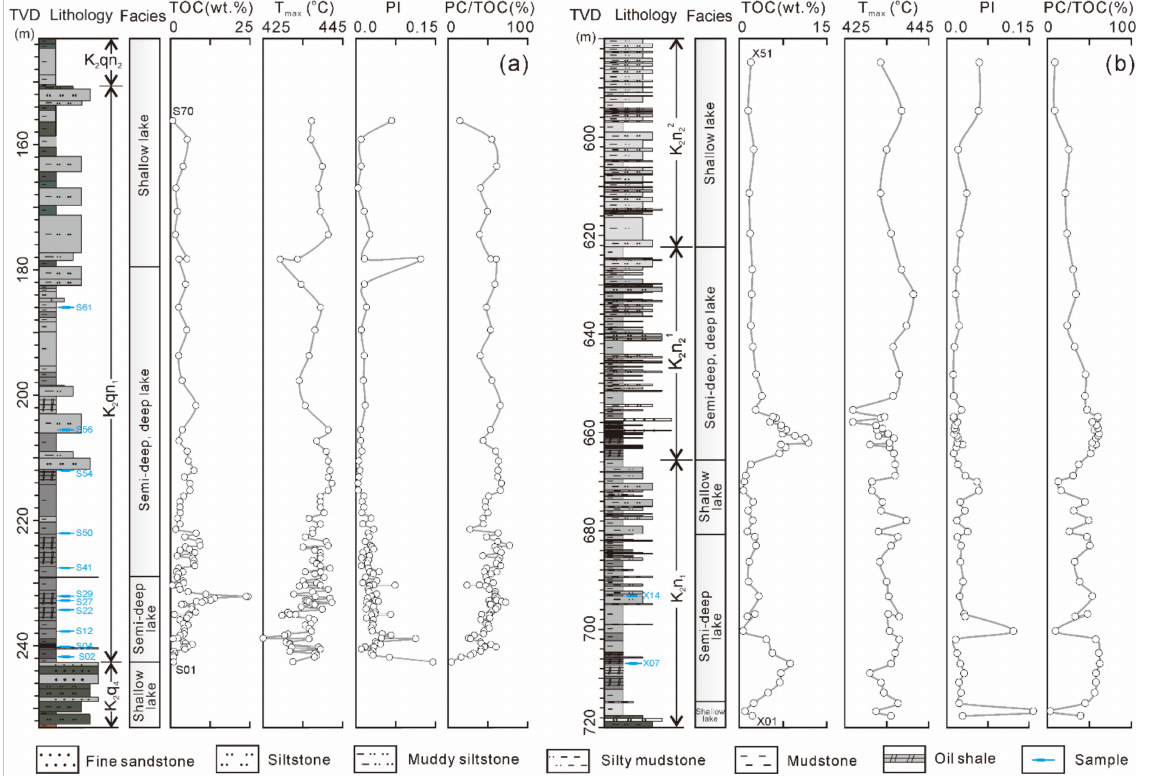
Figure 2. Lithologic profiles and sedimentary facies with position of measured samples from boreholes Ngn2 of the K 2 qn 1 ( a ) and ZK3389 of the K 2 n 1-2 ( b ) in the Songliao Basin, showing TOC contents, T max values, PI values, and PC/TOC ratios from two boreholes. TVD = true vertical depth. Table 1. Layer-specified parameters of grain size fractions from lacustrine oil shales and mudstones in the K 2 qn 1 . Layer Sample Weight M 1 (g) Lower Weight M 2 (g)